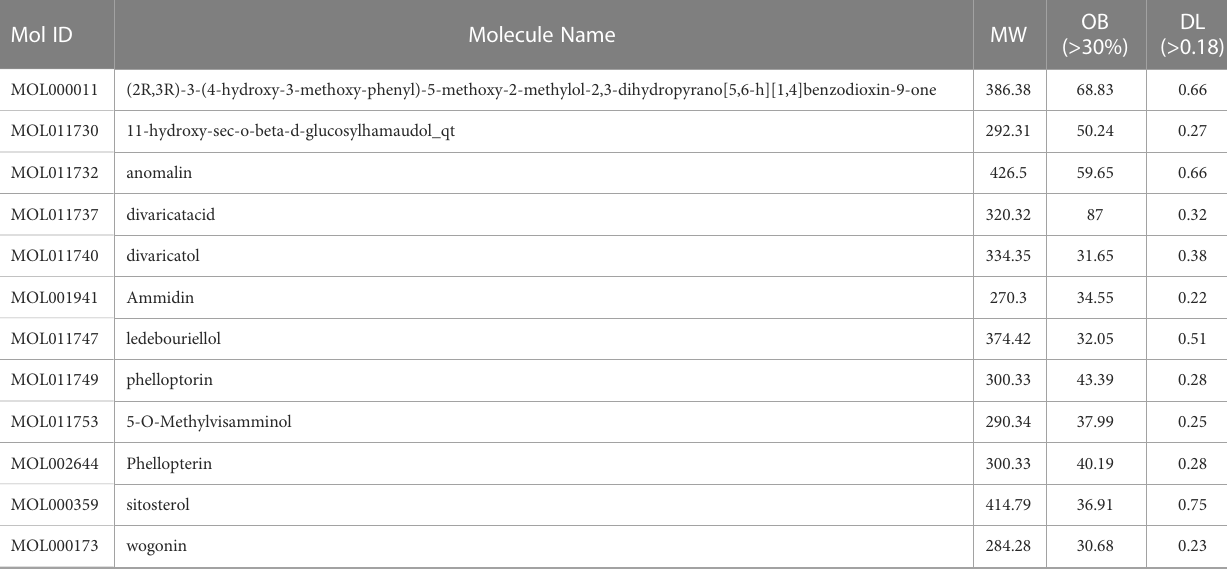
TABLE 3 Bioactive compounds in S. divaricate.